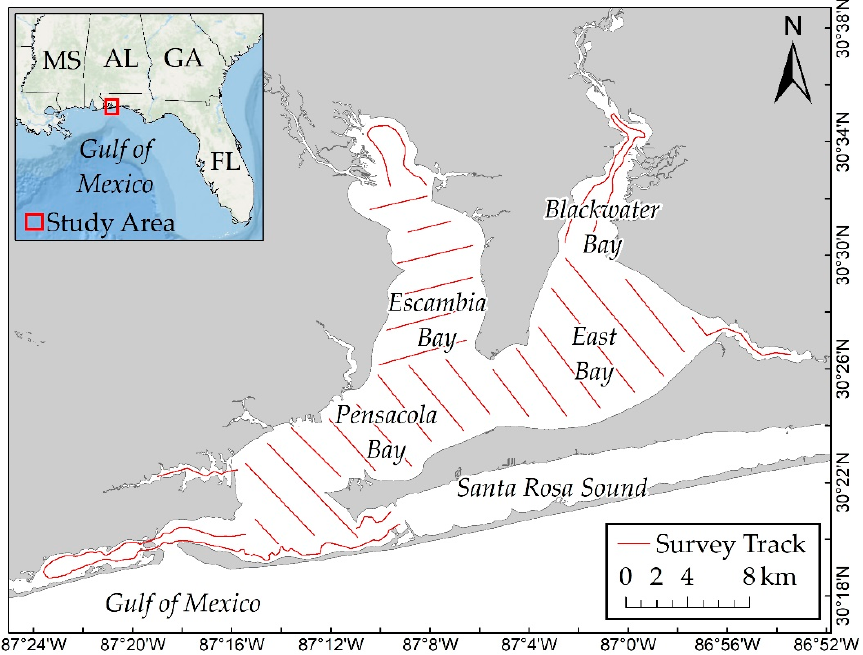
Figure 1. Pensacola Bay estuary system. Red line represents the dolphin survey track. Tracks are spaced approximately 2 km apart or less.